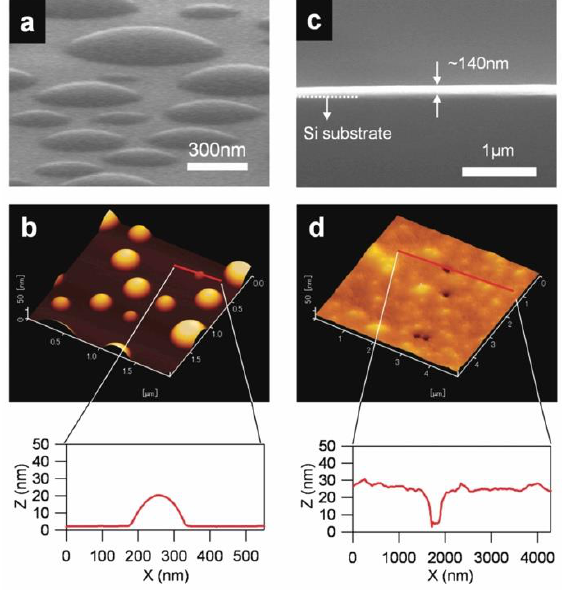
Figure 3. SEM and tapping-mode AFM topographic images, along with their line profiles of [bmim][PF 6 ] on a sapphire(0001) substrate ( a , b ) and [omim][TFSA] on a Si(100) substrate ( c , d ). Reproduced with permission from ref. [18]. Copyright 2011, American Chemical Society.